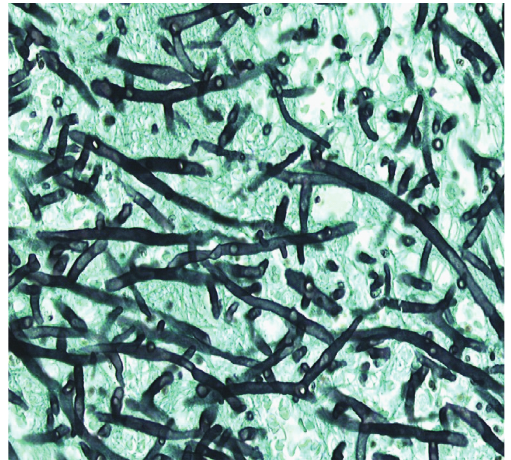
Figure 2: Histology of the intracardial mass showing a great amount of fungal hyphae, characterised by irregular wide, non- septated hyphae with right angle branching, consistent with zygomycetes (Grocot stain, magnification